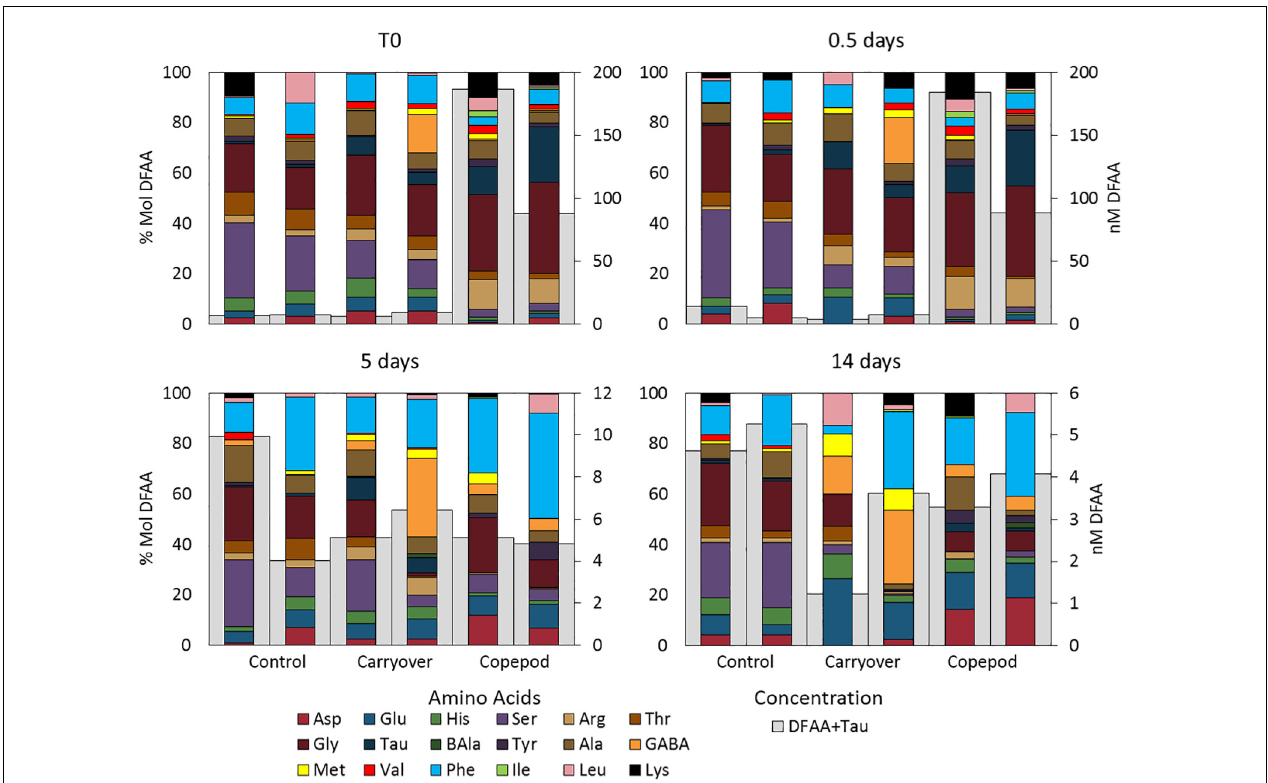
FIGURE 5 | Total DFAA + Taurine concentration (nM; right axis) and %Mol contribution (left axis) of each of the amino acids over the course of the remineralization experiment. Note the different scale bars for total